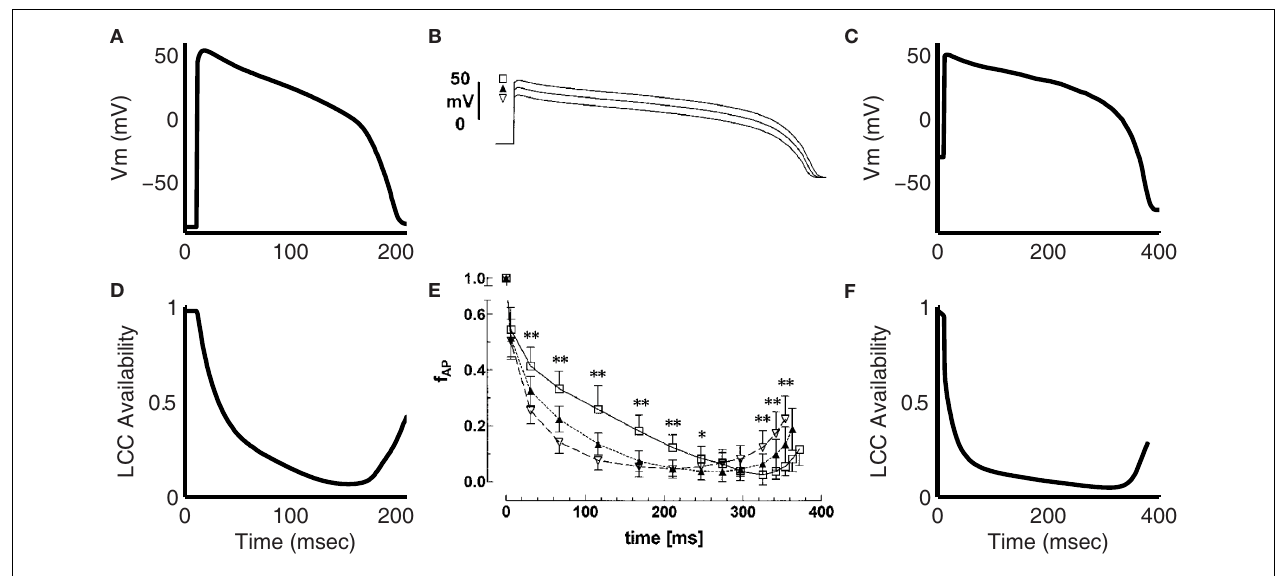
myocytes at 35˚C. (C) Shows model membrane potential output using the trace from (B) as an AP clamp.The LCC availability during the AP clamp is given in (F) . (B,E) Were reproduced by copyright permission of JohnWiley and